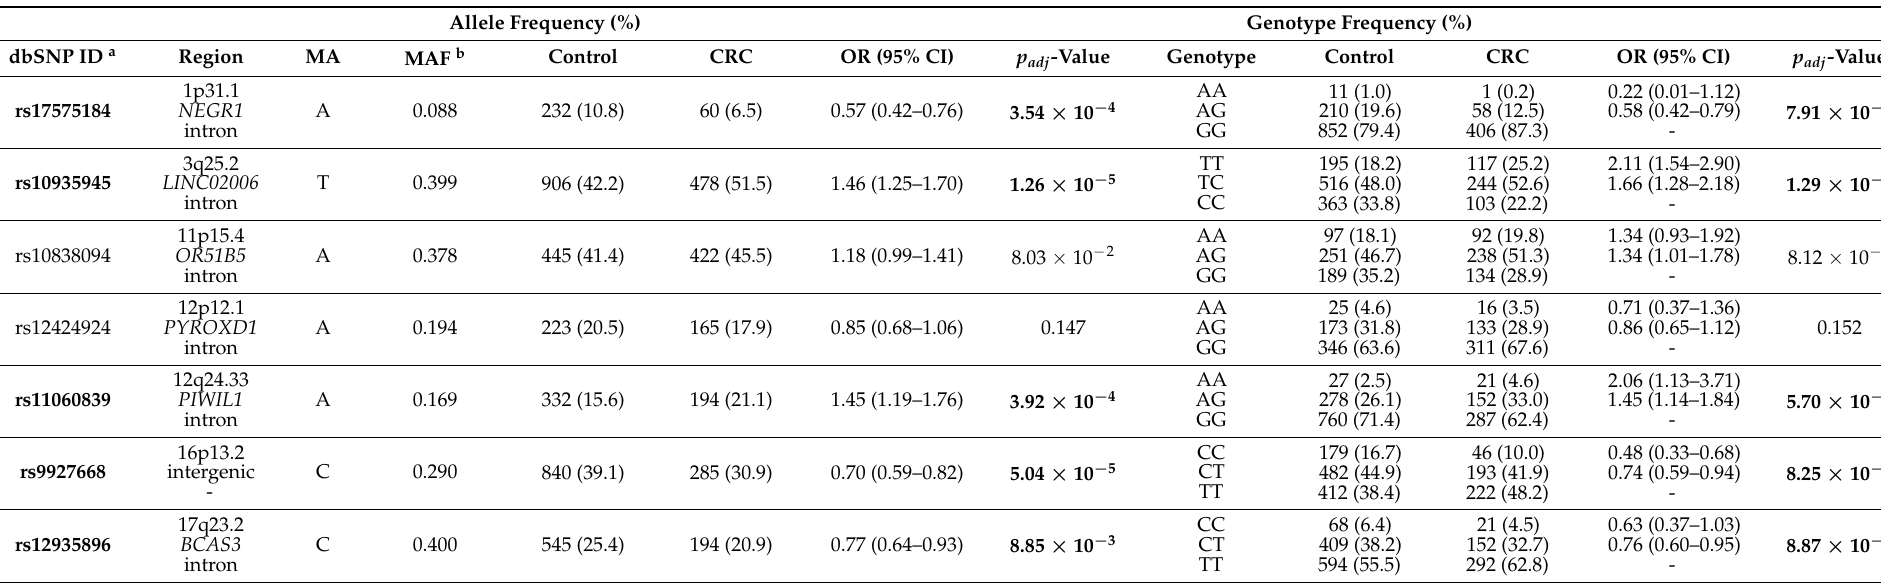
Table 2. The allelic and genotypic association of GWAS-selected, single-nucleotide polymorphisms (SNPs) with colorectal